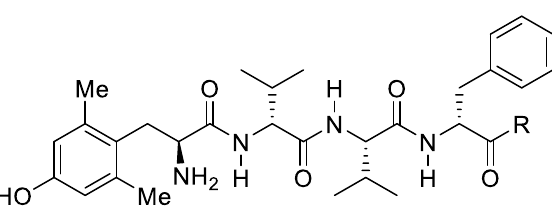
Figure 5. Structures of bilorphin and bilactorphin. Bilorphin, R = NH 2 ; Bilactorphin, R = L-Ser( β -Lac)-NH 2 .